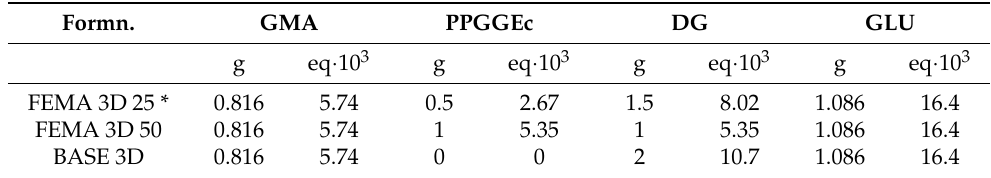
Table 5. 3 ‐ D printing formulations. Table 5. 3-D printing formulations.